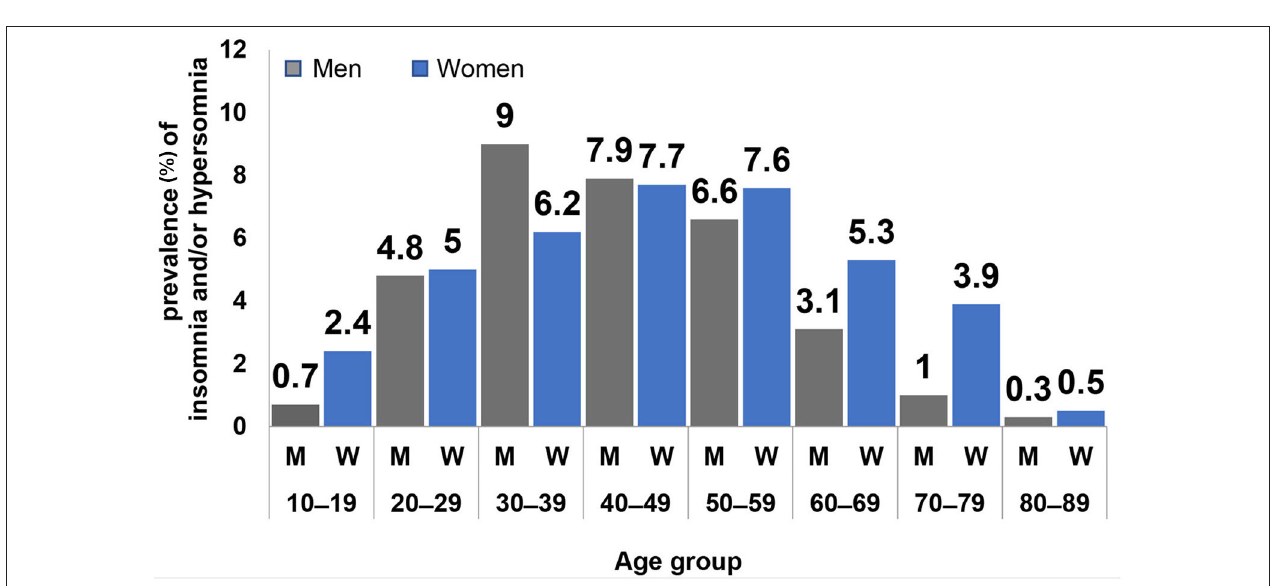
FIGURE 7 | Prevalence (%) of insomnia and/or hypersomnia, stratified by men (M), and women (W) as well as by age group (decades).